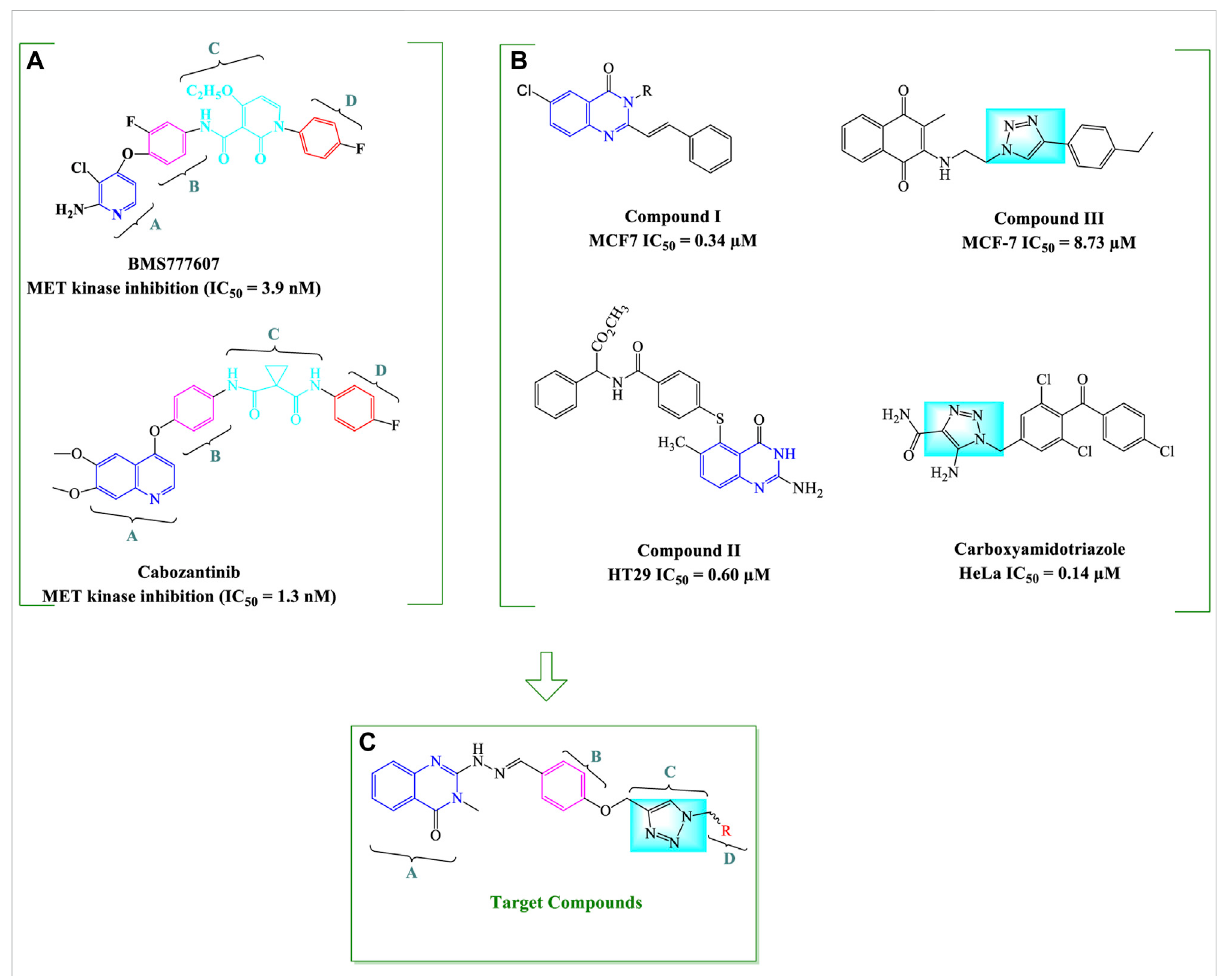
FIGURE 2 General strategy for the design of quinazolinone-hydrazide-triazole hybrids. The important structural features of two type II MET inhibitors BMS777607 and cabozantinib (A) and chemical structures of some potent antiproliferative compounds bearing 4-quinazolinone and 1,2,3-triazole moieties (B) aswellasthegeneralstructureofdesignedquinazolinone-hydrazide-triazolehybrids (C) areshown(Baeketal.,2004;Raffaetal.,2004; Underiner et al., 2010; Yakes et al., 2011; Xu et al.,